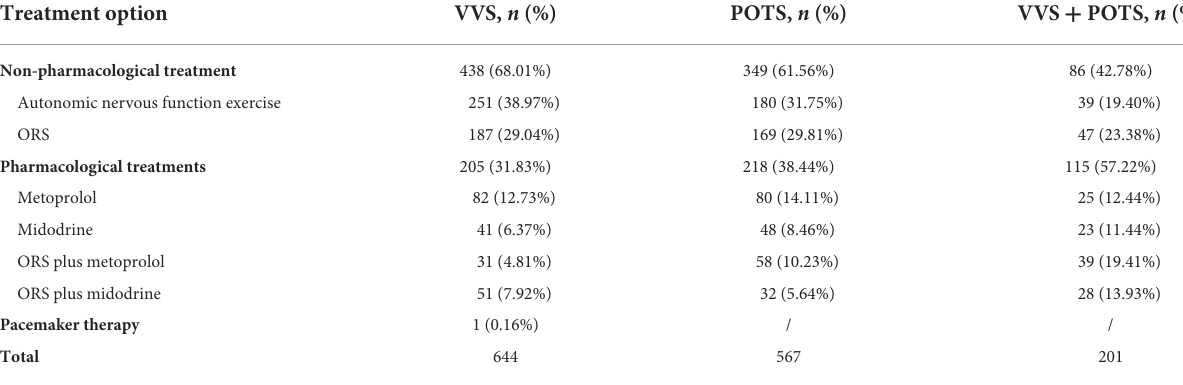
TABLE 3 The proportions of treatment options in children with VVS, POTS, and VVS coexisting with